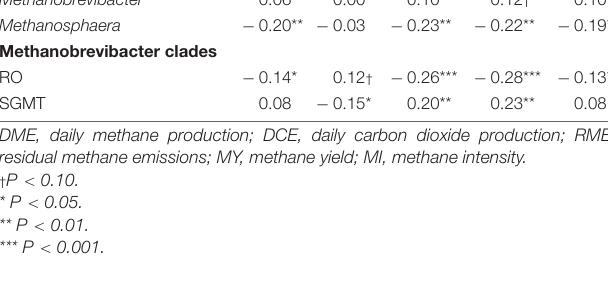
TABLE 4 | Characterization of the rumen methanogens in finishing beef cattle ranked for residual methane. Rumen methanogens